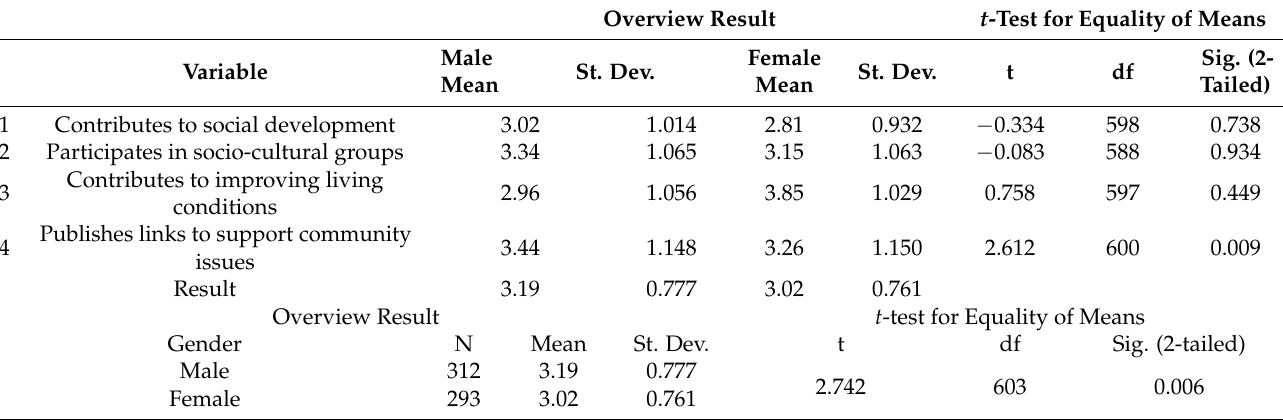
Table 6. Gender comparison: Civic participation.